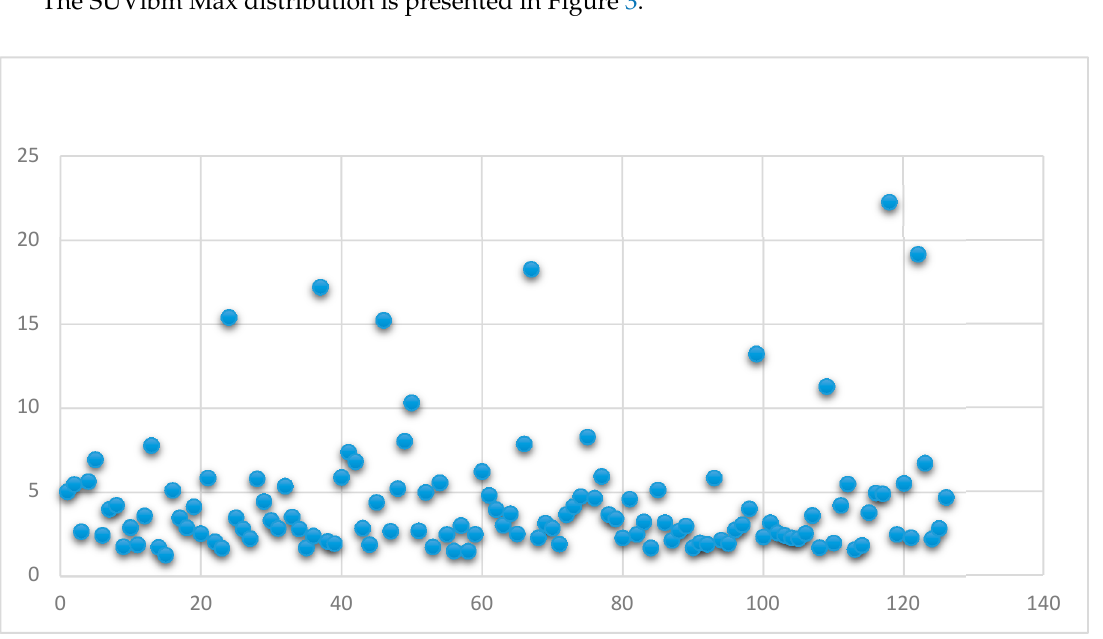
Figure 3. SUVlbm Max distribution.